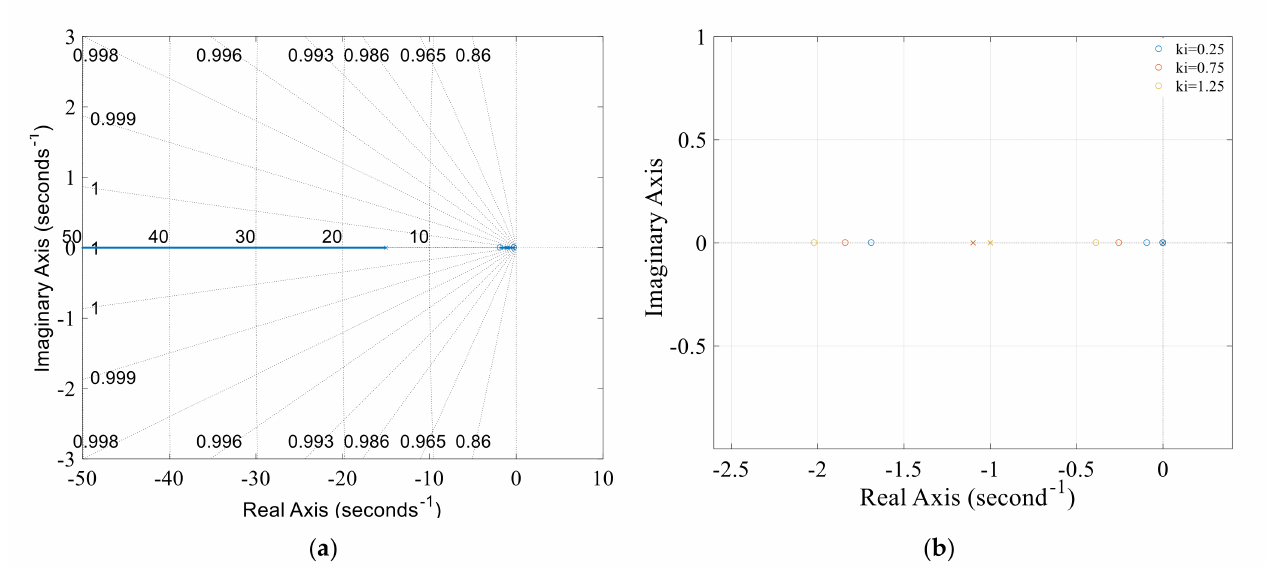
Figure 16. Root-locus response to the variation of the proportional adjustment coefficient, k p = [0.8, 2.4]. ( a ) Root-locus response at k p = 1.6, k i = 0.75 and k d = 0.5, and ( b ) root-locus response with the variation of k p = 0.8, 1.6 and 2.4.